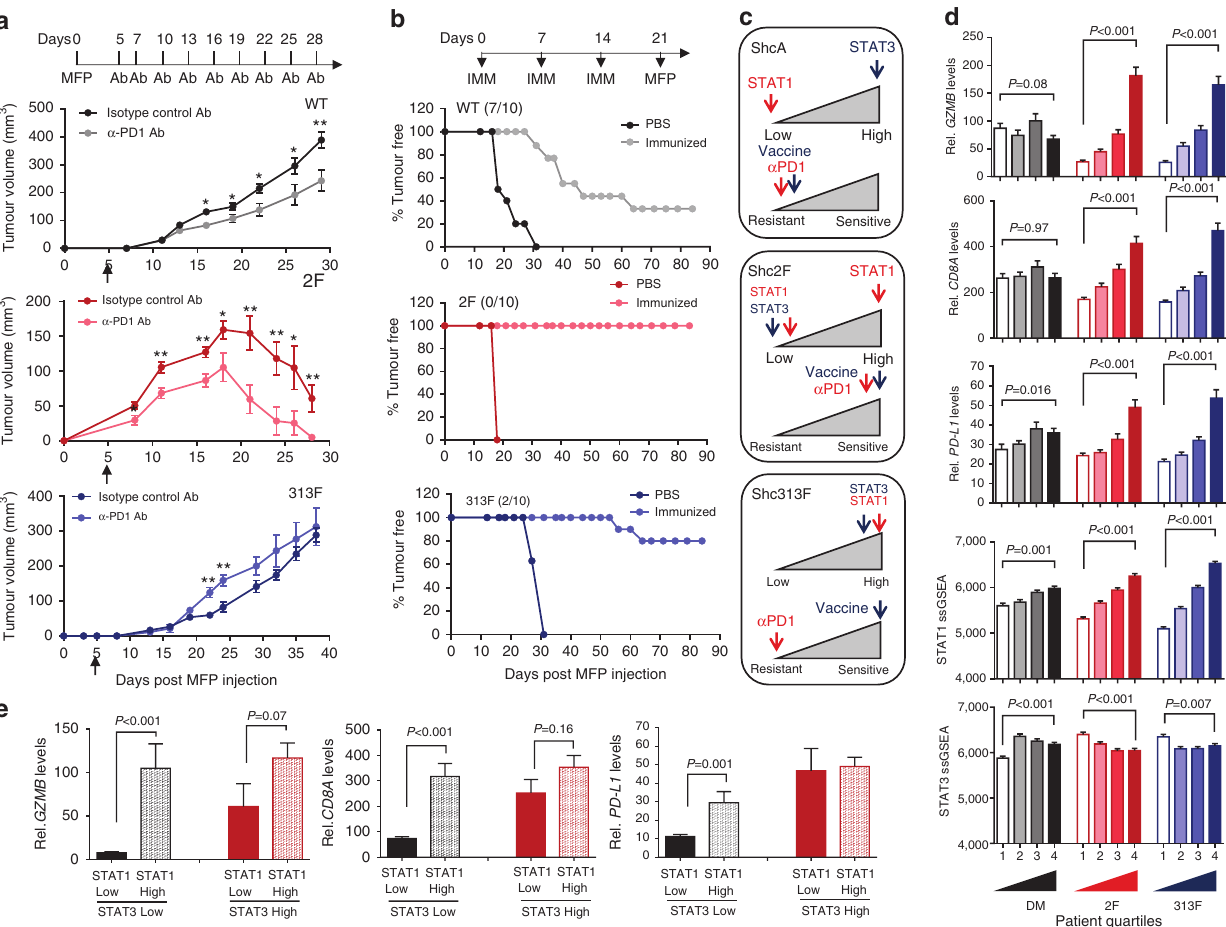
Figure 6 | Distinct ShcA signalling networks differentially sensitize mammary tumours to immunotherapies. ( a ) Mammary fat pad injection of FVB mice with the indicated cell lines. Starting on day 5, mice were treated with 100 m g of a neutralizing PD1 ( a -PD1) antibody or its corresponding isotype control IgG and every 3 days thereafter ( n ¼ 10 tumours each). Data represented as mean ± s.e.m. ( b ) FVB mice received three intraperitoneal injections (days 0, 7 and 14) with PBS or mitomycin C-treated breast cancer cells of the indicated genotypes. On day 21, mammary fat pad injections were performed with breast cancer cells of the same genotype used for vaccination ( n ¼ 9–11 mice each). ( c ) Schematic diagram illustrating the relationship between ShcA- driven, STAT1/STAT3 activation and sensitivity to PD1 immune checkpoint inhibitors or tumour vaccination strategies. ( d ) Primary breast tumours from the TCGA RNAseq data set ( n ¼ 1,215) were equally stratified into four quartiles based on gene expression signatures that are either unique to loss of the Y239/240 (2F) or Y313 phosphorylation site (313F), or shared in both groups (double mutant, DM). ssGSEA was used to rank order each tumour based